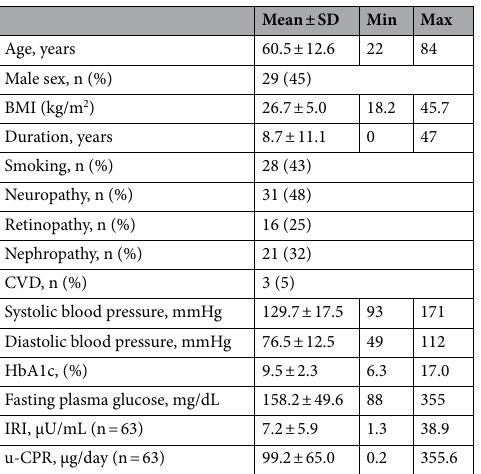
Table 1. Baseline characteristics (n = 65). Data are mean ± SD, n, or n (%). SD, standard deviation; BMI, body mass index; HbA1c, hemoglobin A1c; CVD, cardiovascular disease; IRI, immunoreactive insulin; u-CPR, urinary C-peptide